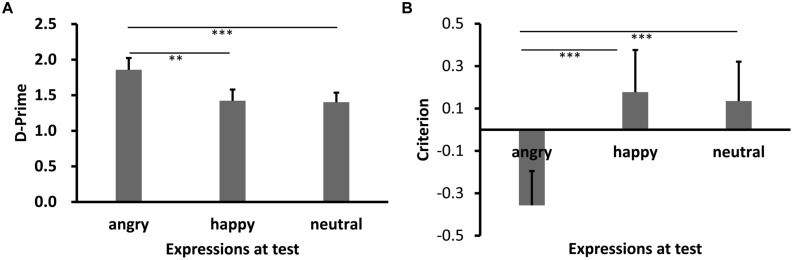
Sensitivity d′ (A) and Criterion c (B) results as a function of test expression (Experiment 2b). Error bars represent 1 SEM. ∗∗p < 0.01; ∗∗∗p < 0.001.